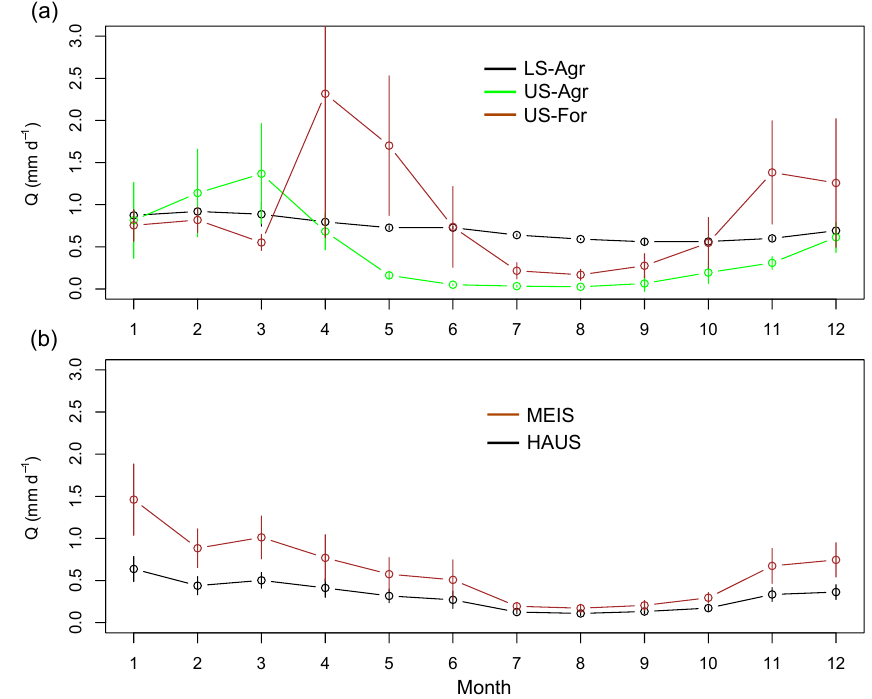
Figure 2. Monthly discharge in headwater catchments (a) and downstream catchments (b) . Error bars represent the standard deviation ( n = 2–10 years). Table 1. Coefficient of variation (CV; mean ± standard deviation, n = 2–10 years) of daily discharge (Q), concentrations and N:P